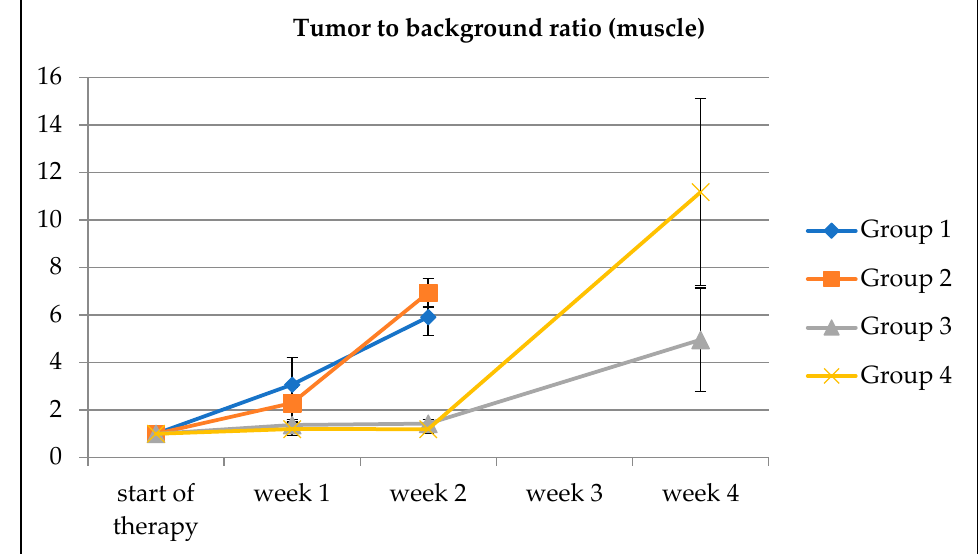
Figure 6. Tumor to background ratios with VOIs in the muscle (M. quadriceps femoris) as background. Error bars indicate the standard error of the mean.